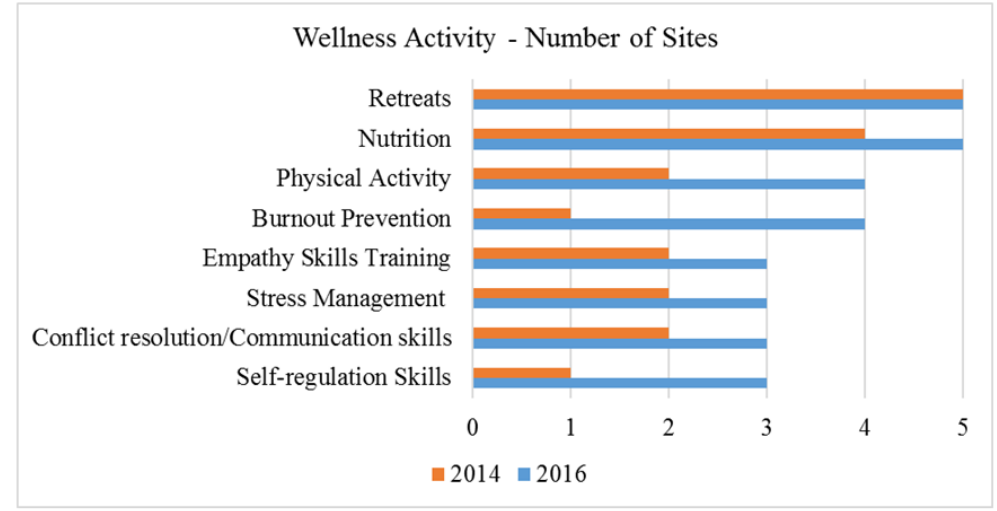
Figure 1. On-site physician wellness activities—number of sites by year.